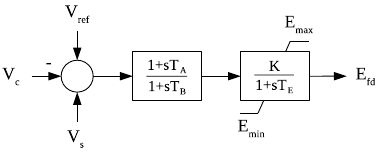
Figure 3. Block diagram of AVR controller.